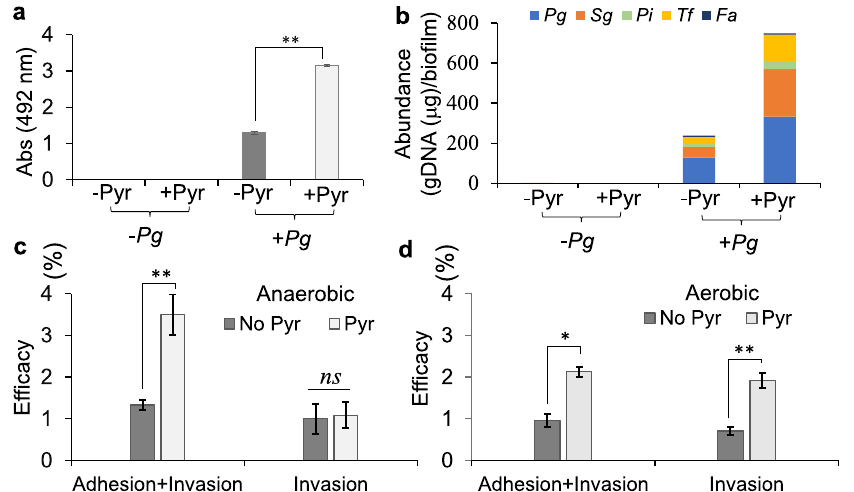
Fig. 6 The impact of the co-utilization of pyruvate and human serum by P. gingivalis on development of multispecies bio fi lms, host colonization, and invasion. a Multispecies bio fi lm assay shows that P. gingivalis is necessary for the formation of a heterotypic community composed of S. gordonii, T. forsythia, P. intermedia , and F. alocis when human serum (5%) is used; pyruvate addition (0.5%) augments the biomass of the heterotypic bio fi lm. b Graph shows relative abundance of each species in each mixed bio fi lm that is calculated on the basis of the quanti fi cation of the genomic DNA of individual population using qPCR and 16S ribosomal RNA primers. c , d Graphs show the ef fi cacy of colonization and invasion of the primary HGEP cells by P. gingivalis (MOI of 100 and incubated for 1 h) when grown in human serum with and without adding pyruvate, incubated under anaerobic ( c ) or aerobic ( d ) conditions. Pyruvate availability signi fi cantly increases the adherence of P. gingivalis to the primary HGEP under both aerobic and anaerobic conditions; but invasion was augmented when the interaction was aerobically incubated. Bio fi lm graph represents the mean ± SE (two biological replicates, in each n = 3) of biomass incubated for 48 h. Obtained data were normally distributed (Shapiro – Wilk test: p > 0.05), and thus analyzed using ANOVA test. Asterisks indicate pairs of signi fi cantly different values (post hoc Tukey ’ s HSD test: ** p < 0.01). Values in graphs are shown as the mean ± SE of CFU obtained from two independent experiments, each with four replicates, and were analyzed with a Student ’ s t test (* p < 0.05; ** p < 0.01; ns nonsigni fi cant).